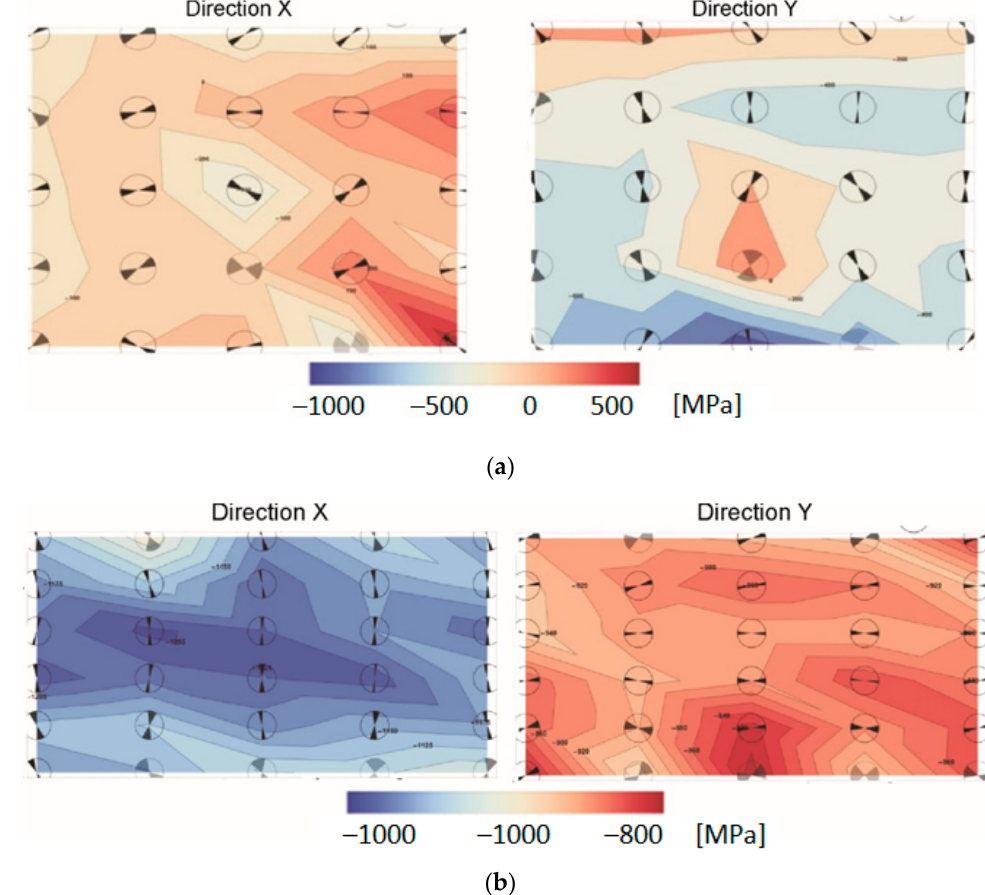
Figure 14. The maps of residual stresses measured in two perpendicular directions X and Y in the ( a ) AA2519 alloy and ( b ) Ti6Al4V; description in text.